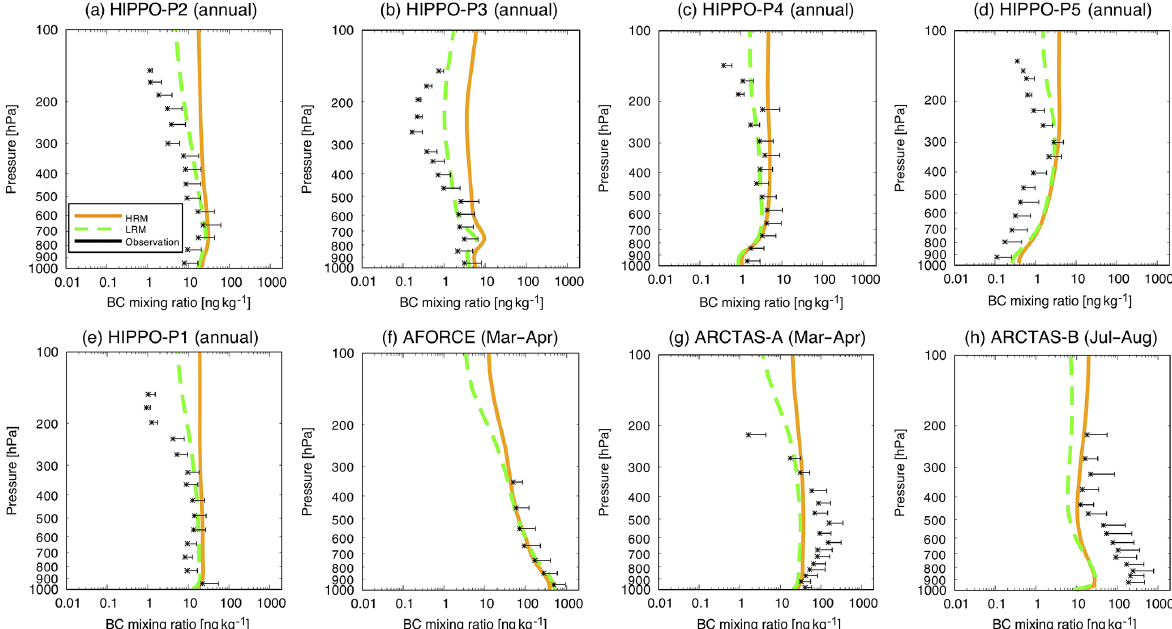
Figure 14. Vertical distribution of the BC mass concentrations from the NICAM simulations (HRM in orange and LRM in green) and from flight campaign measurements (the groups by NOAA and the University of Tokyo) in various regions and seasons. The definitions of the target domain and period in each panel are as follows: (a) 20–60 ◦ N, 160 ◦ E–150 ◦ W, (b) 20 ◦ S–20 ◦ N, 160 ◦ E–150 ◦ W, (c) 60–20 ◦ S, 160–150 ◦ W, (b) 60–80 ◦ S, 160–150 ◦ W, and (e) 60–90 ◦ N, 160 ◦ E–150 ◦ W, in annual averages of 2009, (f) 32–37 ◦ N, 122–126 ◦ E, in March 2012 and 26–32 ◦ N, 126–132 ◦ E, in April 2012, (g) 60–80 ◦ N, 165–70 ◦ W, in March–April 2008 and (h) 45–87 ◦ N, 135–45 ◦ W, in July–August